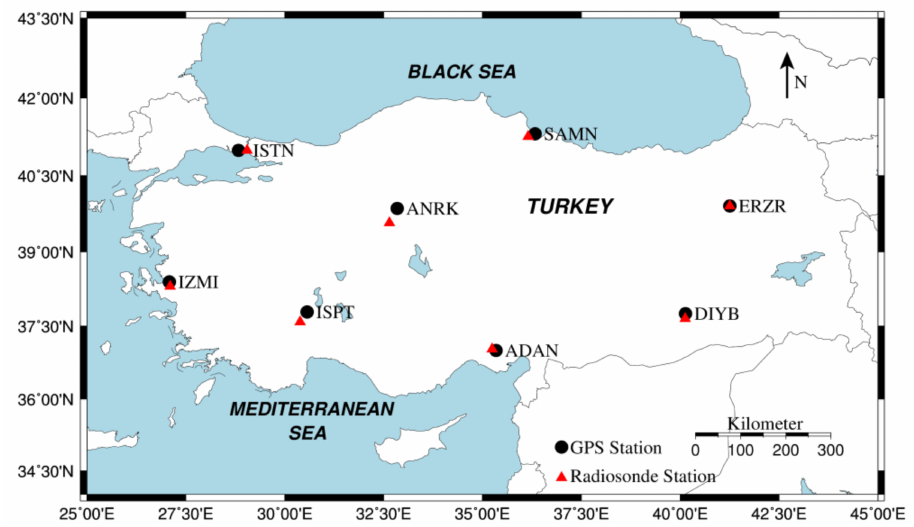
Figure 1. GPS and radiosonde stations